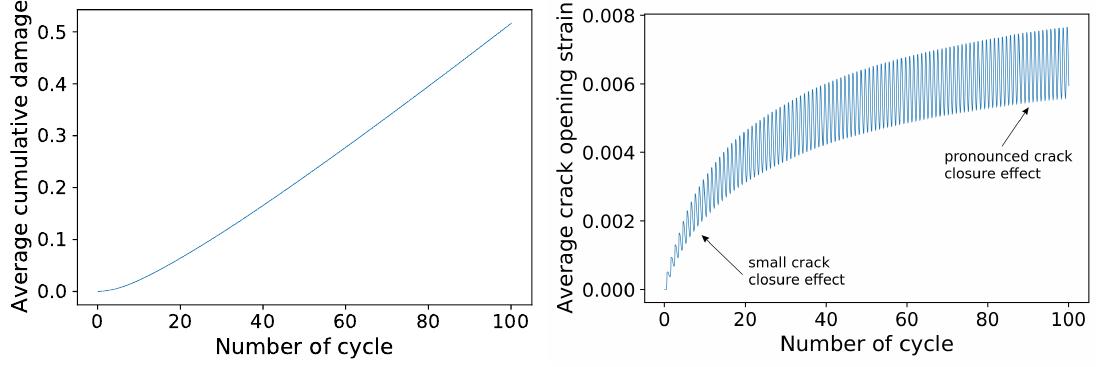
Figure 16. Cumulative damage across the entire microstructure ( left ) and average crack opening strain for all opening damage systems ( right ) under cyclic